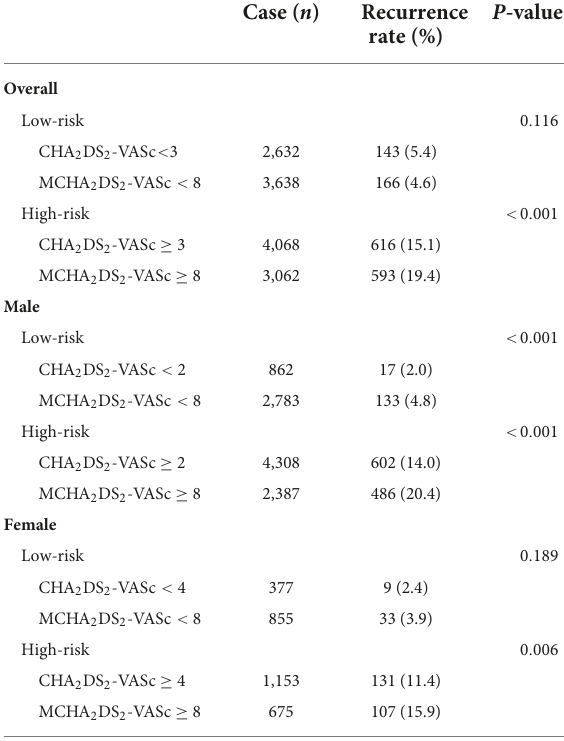
TABLE 5 Comparison of CHA 2 DS 2 -VASc and MCHA 2 DS 2 -VASc scores for incidence of recurrent myocardial infarction, presented overall, and stratified by